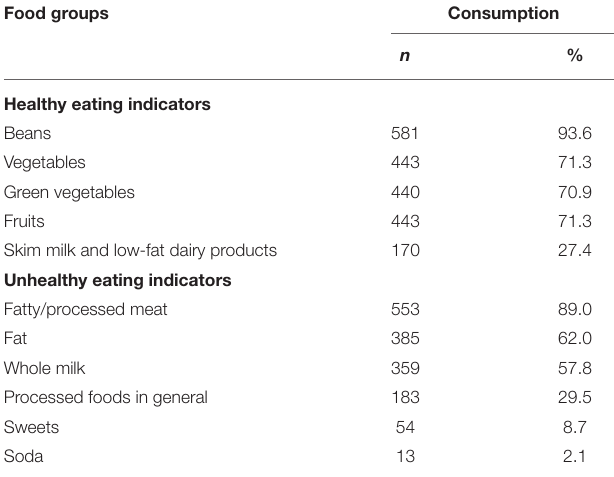
TABLE 3 | Frequency of regular consumption of food groups, listed under healthy and unhealthy eating indicators, Viçosa, State of Minas Gerais, Brazil, 2009 ( n =